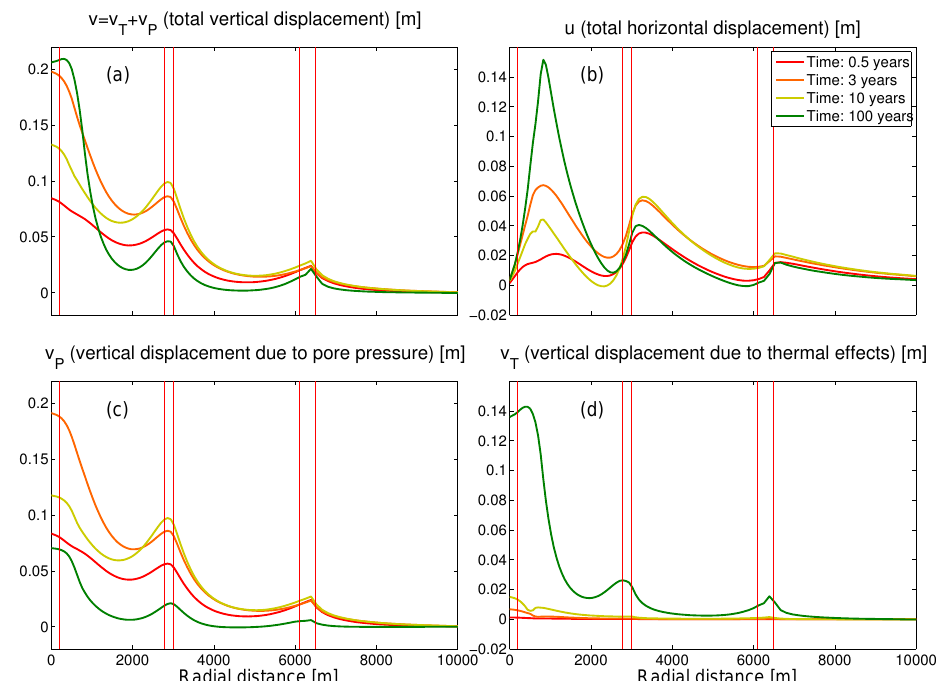
Figure 9. Ground deformation computed for Scenario II at the surface after t = 0 . 5, 3, 10 and 100 years of unrest: total vertical deforma- tion (a) , total horizontal deformation (b) , vertical deformation due to pore pressure (c) , and vertical deformation due to thermal effects (d) . Vertical lines refer to the boundary of the central conduit and to the injection and shallowest points of faults.